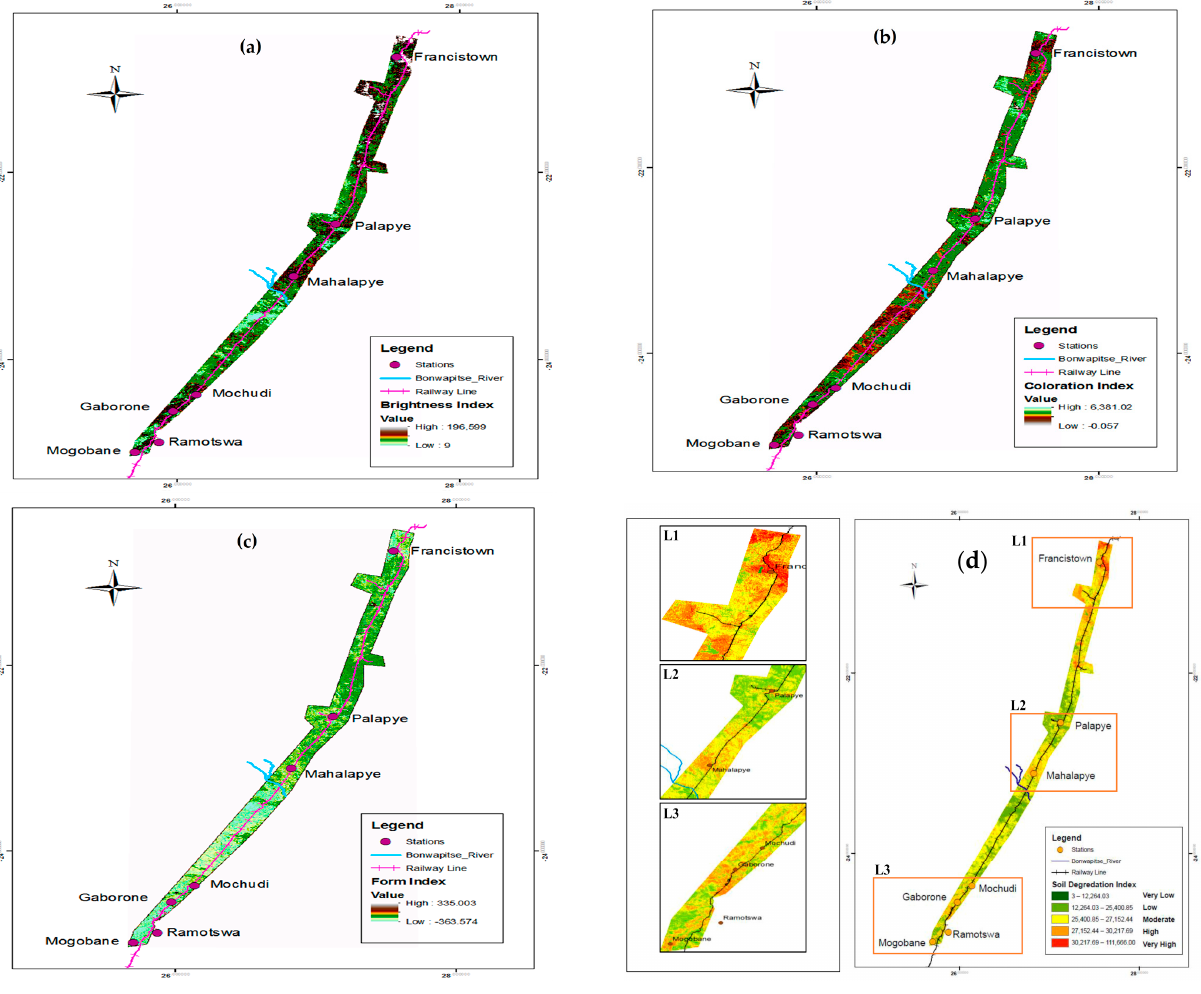
Figure 9. BRC spectral indices: ( a ) Brightness Index, ( b ) Coloration Index, ( c ) Form Index and ( d ) Soil degradation index for the BRC.